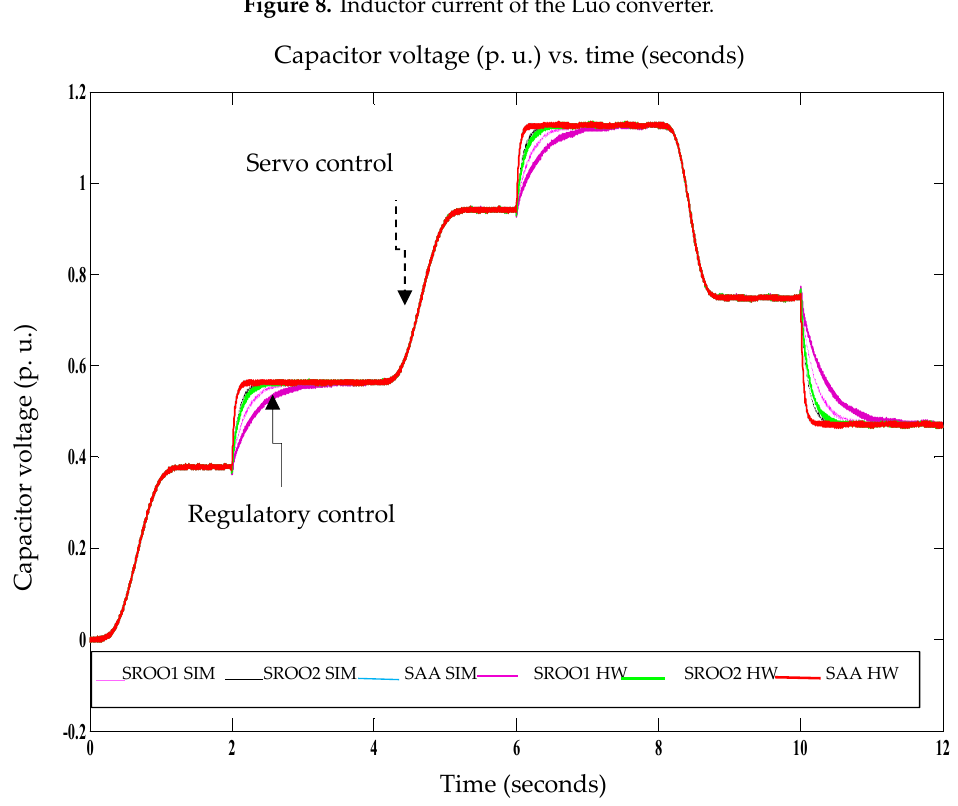
Figure 9. Armature voltage of the Luo converter-fed DC motor.